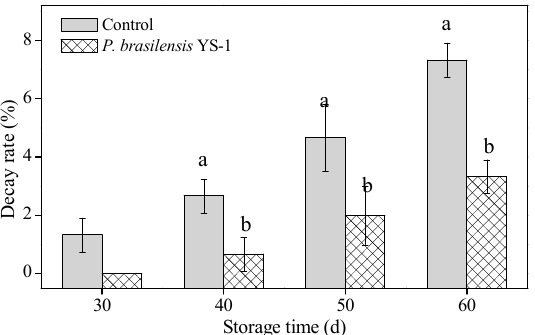
Figure 1. Effect of P. brasilensis YS-1 treatment on the decay rate of citrus fruits stored at 5 ± 0.5 °C for 60 d. Vertical bars represent the mean ± SE ( n = 3). Letters indicate the statistical differences according to the independent samples t -test ( p < 0.05) on each storage day.